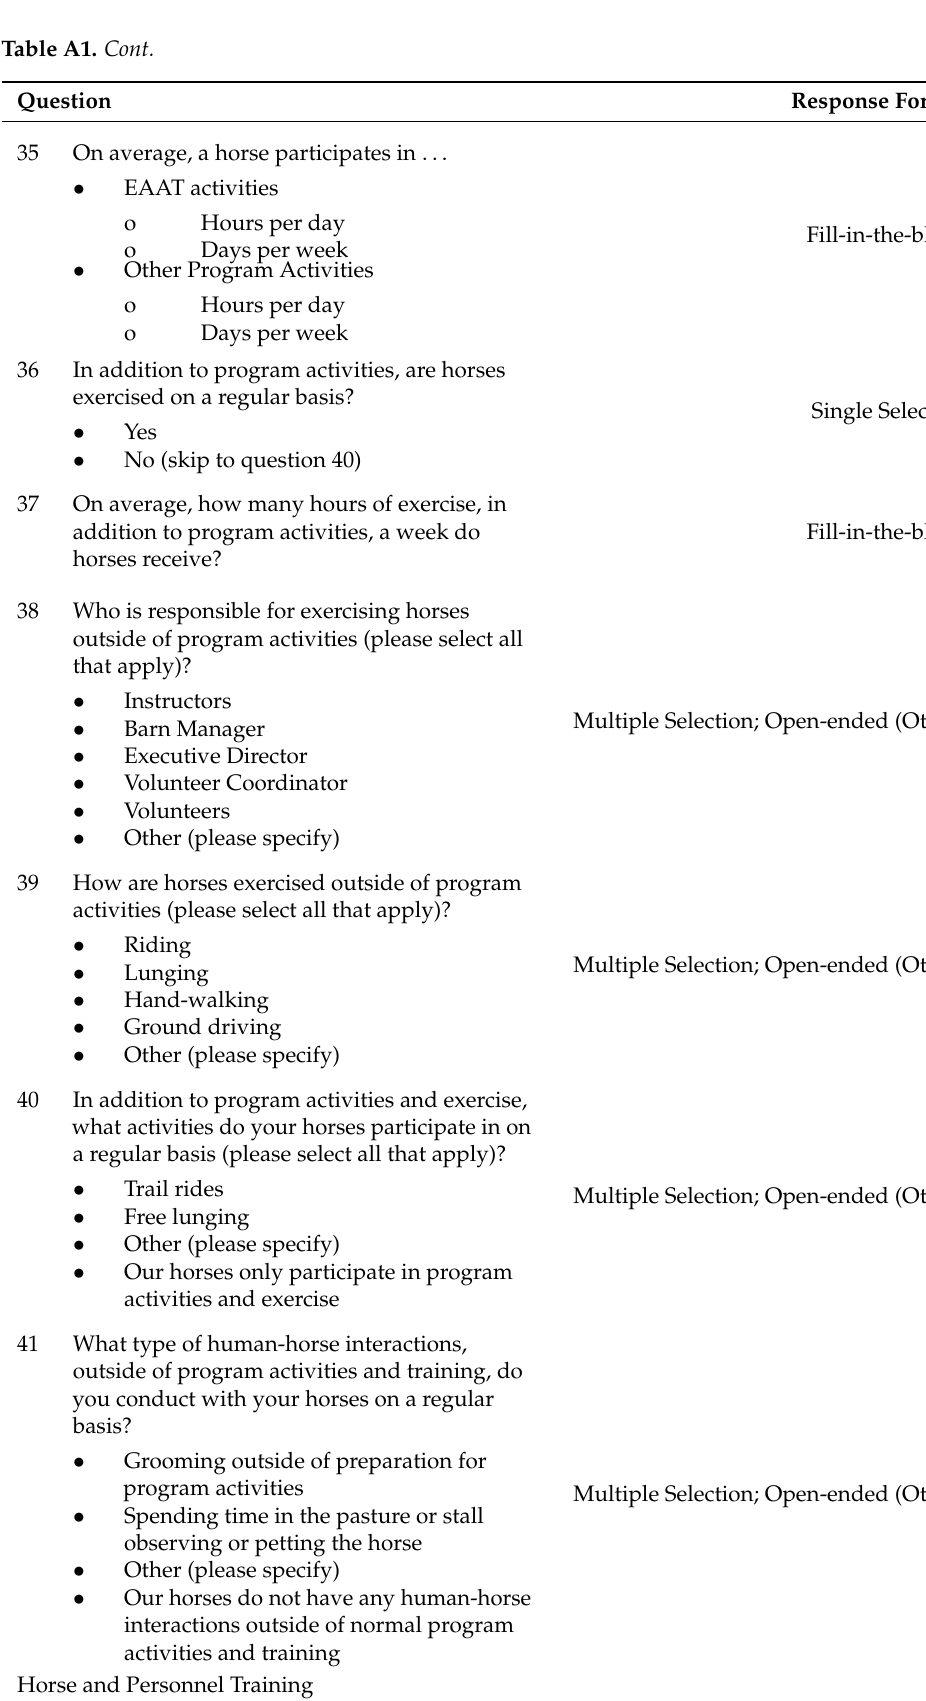
Table A1. Cont. Question Response Format